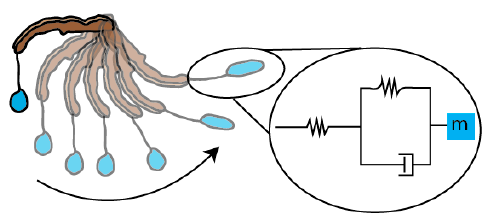
Figure 6. The dynamic behavior of the bolas during flicking, modeled as a simple mass-spring- damper system. The glue droplet is held steady with the leg in a horizontal orientation (top-most position). As the spider swings its leg, the inertia of the flicked glue droplet carries it forward until it reaches the end of its arc. At this moment, the kinetic energy is transduced into elastic energy in the radial thread and the droplet, stretching both (see Figure 4A–C). The system has two springs: (1) the radial thread and (2) the glue droplet, forming the mass-spring-damper system as in the diagram in the inset. The springs are represented by zig-zagged lines, the damper is a piston, and the center of mass is shown by the blue square, m . This model is a first-approximation and, thus, is likely to be highly simplified compared to the actual behavior of the system, which has yet to be determined. Table 2. Bolas droplet acceleration and spring constants during a flick.